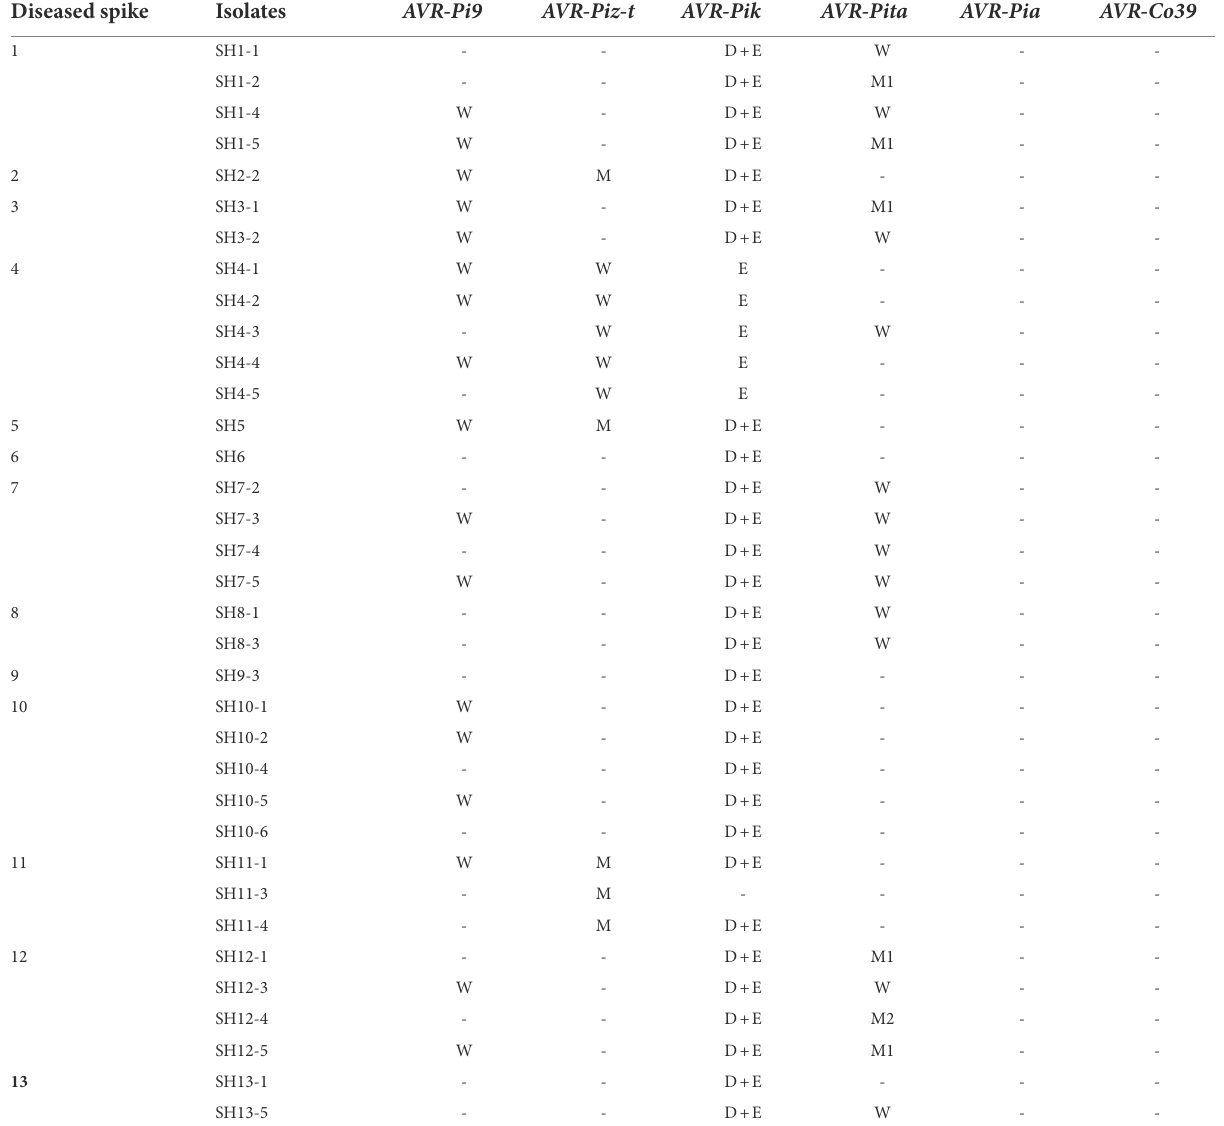
TABLE 1 Analysis of different avirulence ( AVR ) genes in 35 rice blast isolates. Diseased